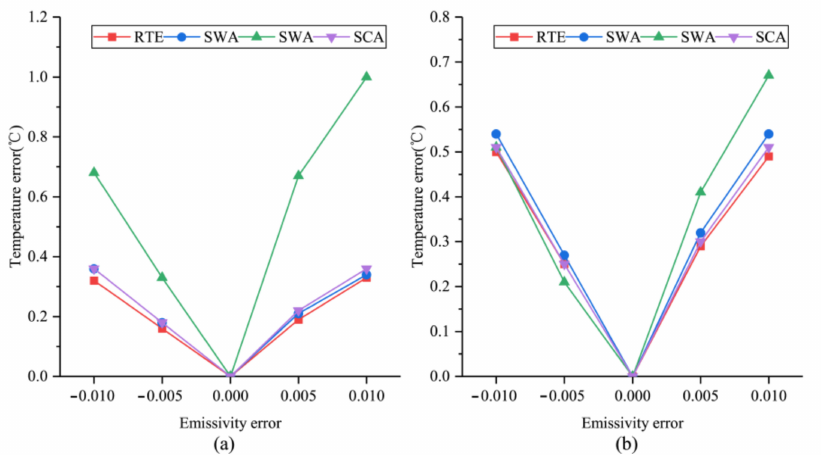
Figure 10. The errors in LST retrieval results due to changes in different parameters. ( a , b ) are the LST estimation errors of MWA due to the estimation error in effective atmosphere